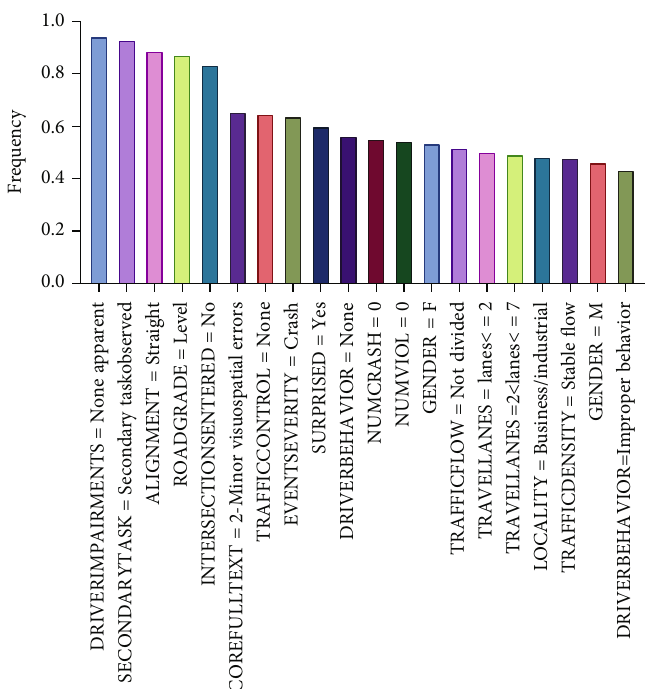
Figure 3: Item frequency in C/NC events.